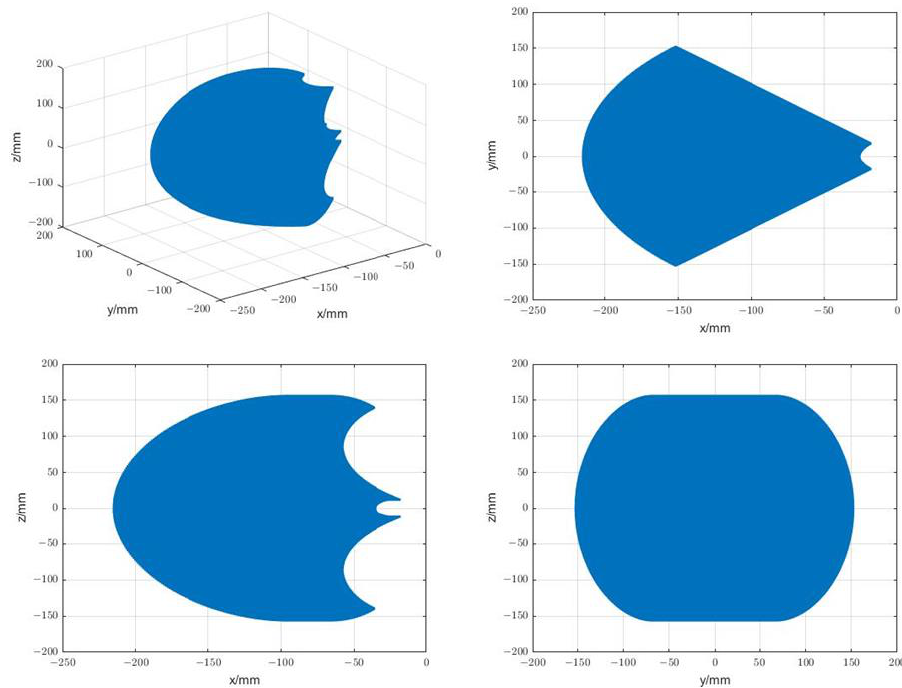
Figure 6. The 3D workspace and 3 plane projections.